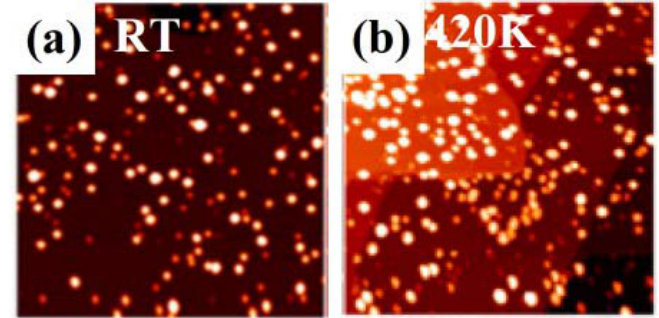
Figure 6. The temperatures and converges are ( a ) RT, 0.65 ML; ( b ) 420K, 0.65 ML; ( c ) 570K, 0.54 ML; ( d ) 650K, 1.05ML; ( e ) Temperature dependence of the island density n from 300 to 650 K. Classical nucleation predicts an Arrhenius dependence of n with temperature while images ( a – d ) instead show an almost constant island density. Each image is 200 × 200 nm 2